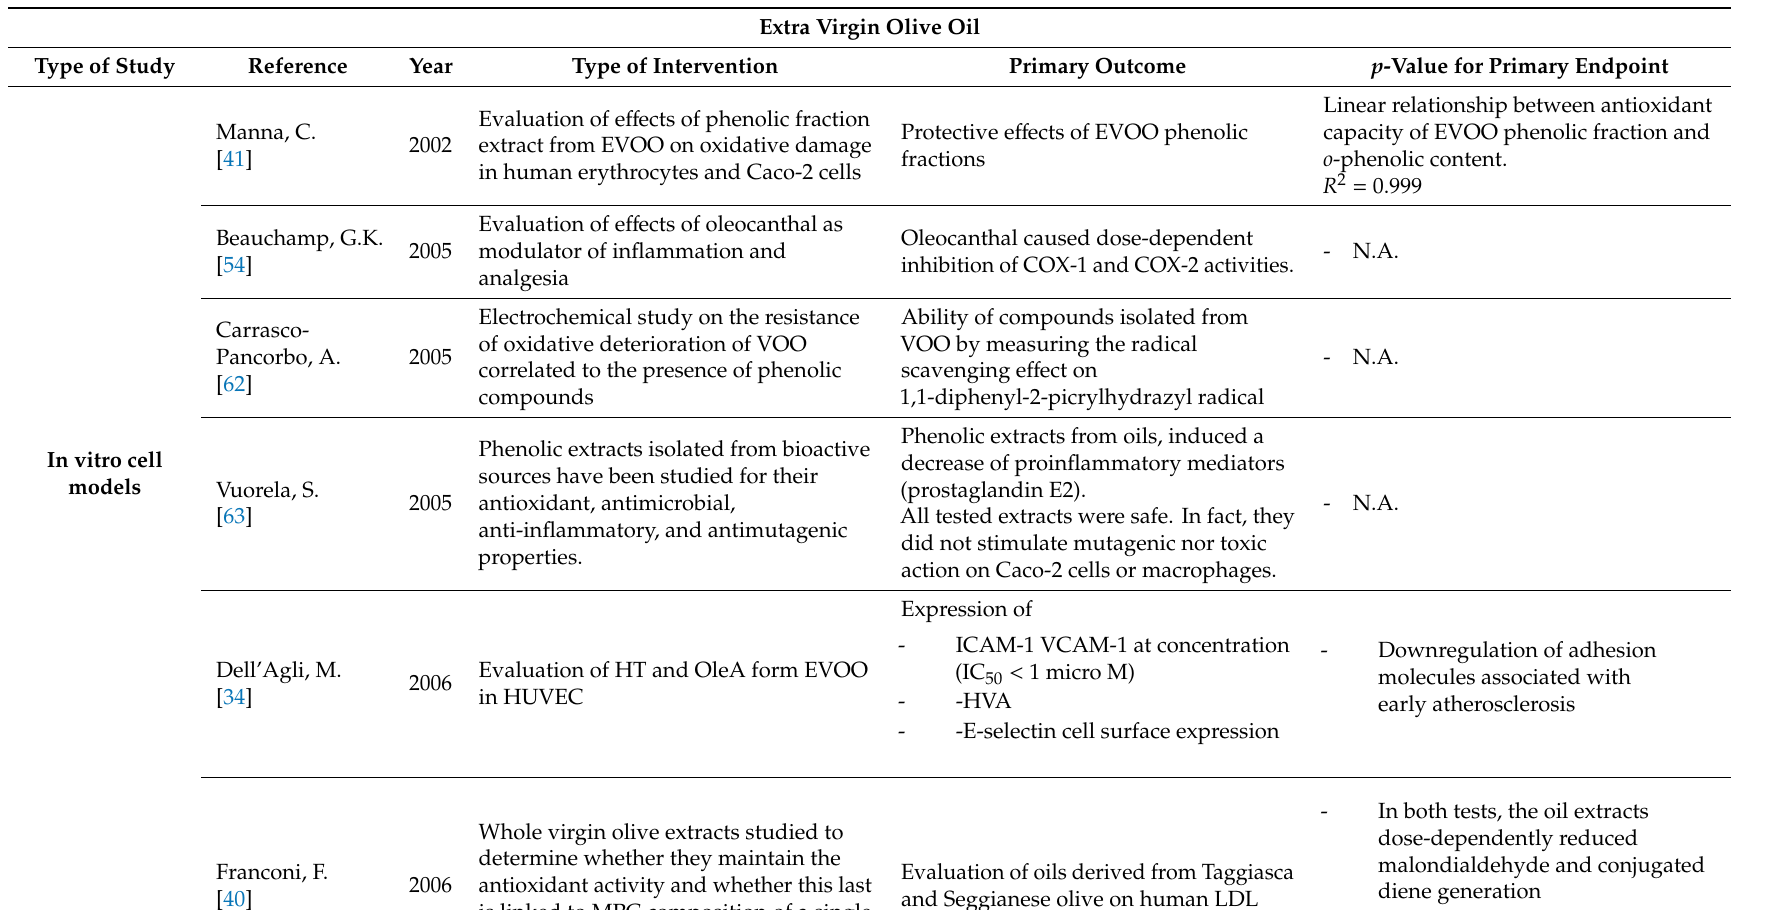
Table 2. Studies on extra virgin olive